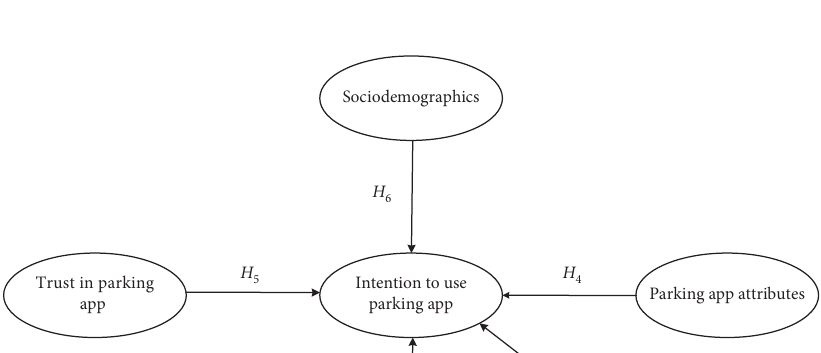
Figure 1: Technology acceptance model (TAM).